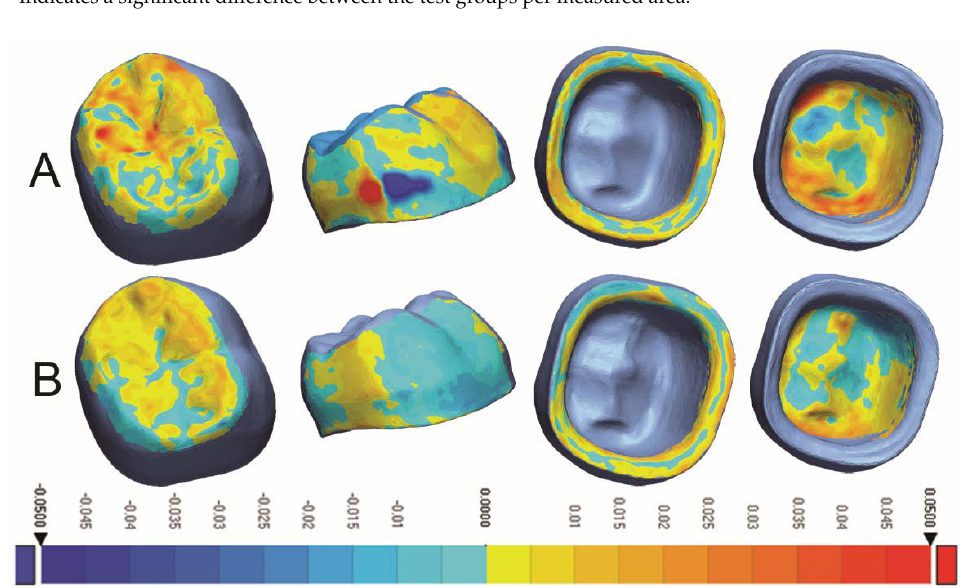
Figure 4. Colorimetric analysis of precision for ( A ) Milled crowns and ( B ) 3D-Printed crowns.